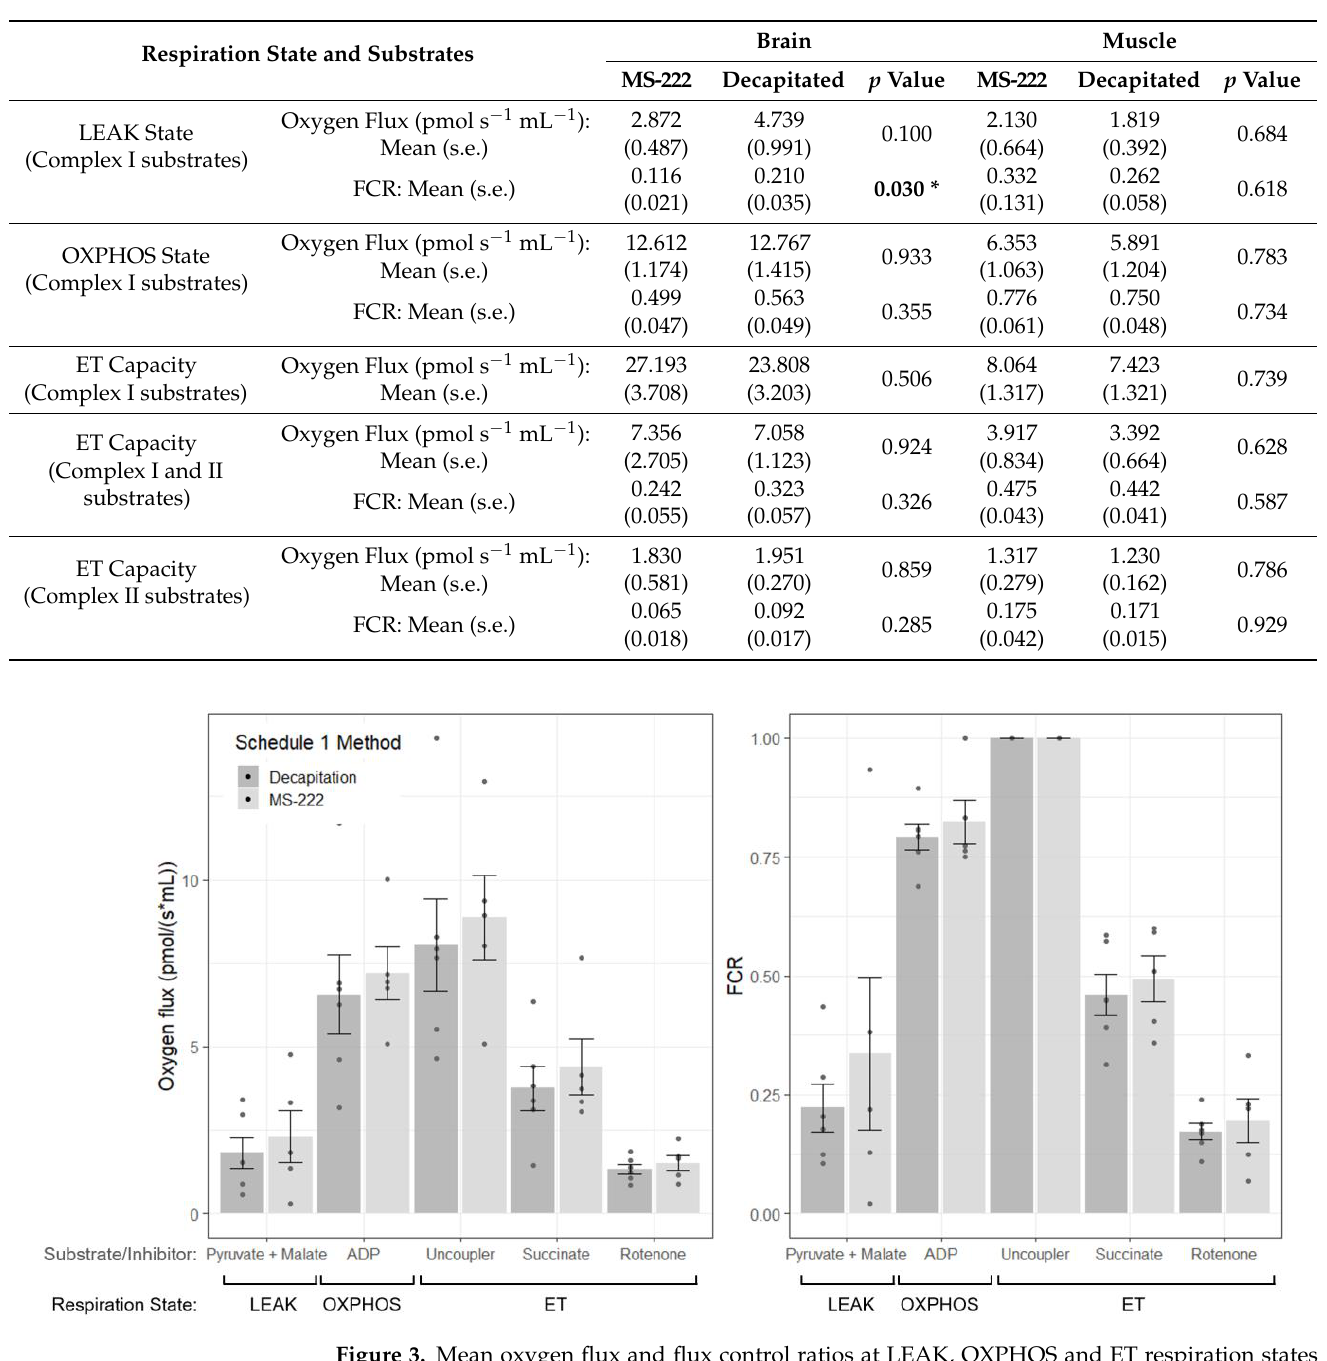
Table 1. Oxygen flux and flux control ration values in the brain and muscle of three-spined stickleback treated with or without MS-222. Unpaired Student’s t -test, significant differences ( p < 0.05) between groups depicted by a star (*).